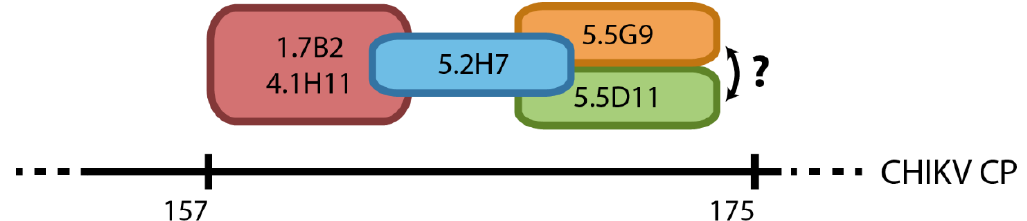
Figure 9. Schematic representation of proposed spatial relationship of epitopes recognized by group 1 anti-CP